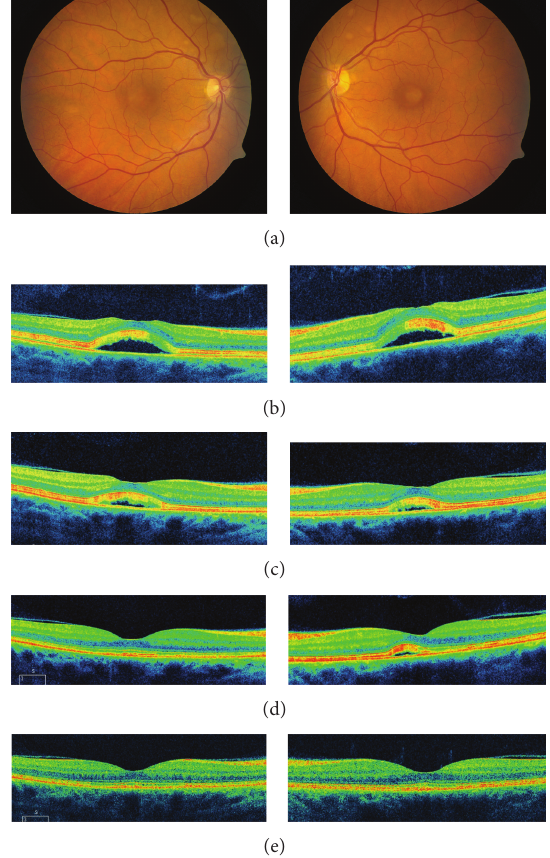
Figure 2: Color fundus photographs (a) and OCT (b) of the right and left eyes on full dose dabrafenib and lower dose trametinib showing recurrence of the multifocal neurosensory detachments. After stopping trametinib, OCT findings improved at 1 week (c), 3 months (d), and 6 months